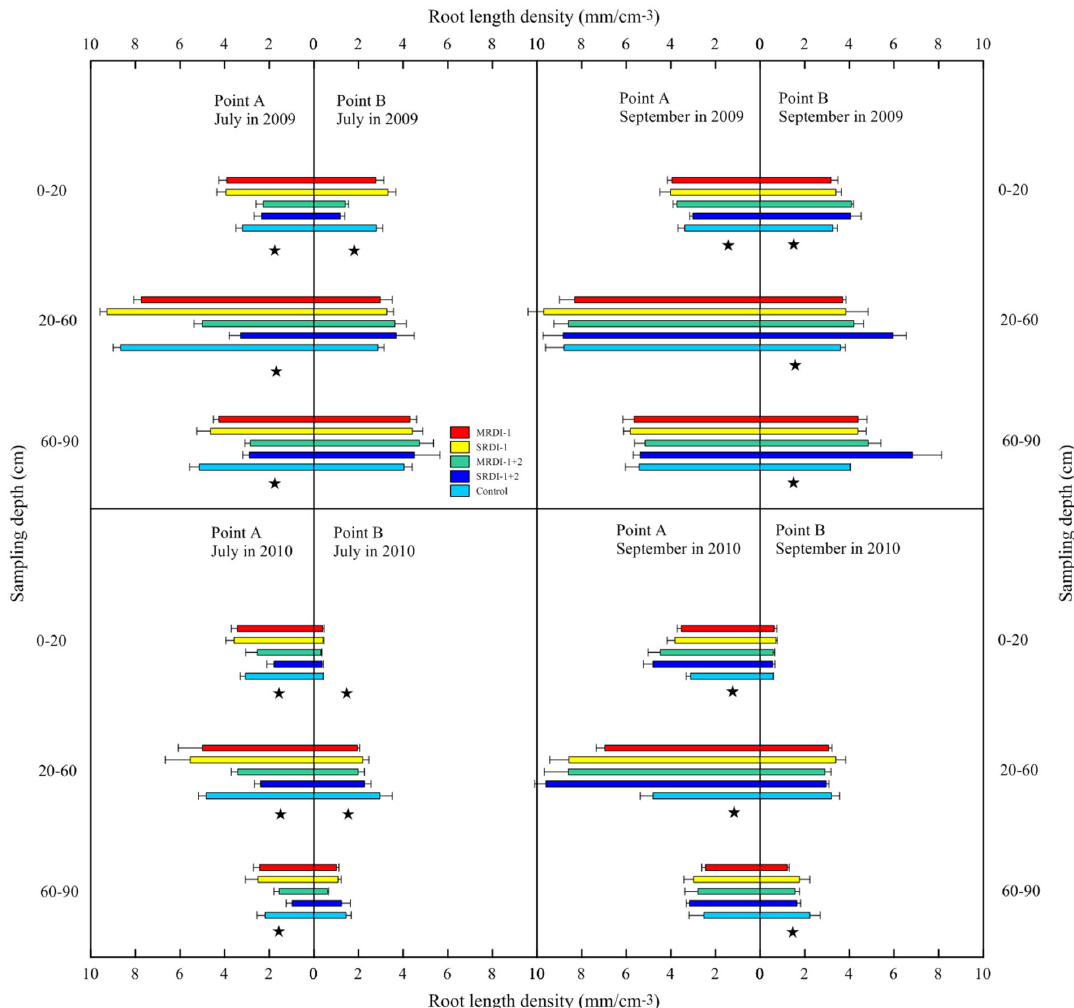
Figure 4. The root length density of each treatment. MRDI ‐ 1 and SRDI ‐ 1 were applied with moderate and severe water stress, respectively, during Stage 1 (0–30 DAB), and fully irrigated during other stages. MRDI ‐ 1+2 and SRDI ‐ 1+2 were applied with moderate and severe water stress applied, respectively, during Stage 1+2 (0–86 DAB), and fully irrigated during other stages. Sampling point A was located in the irrigated zone and sampling point B was located in the non ‐ irrigated zone. Vertical bars represent one standard deviation of the mean. ★ indicates significant differences between various treatments in the same layer at the p < 0.05 level.